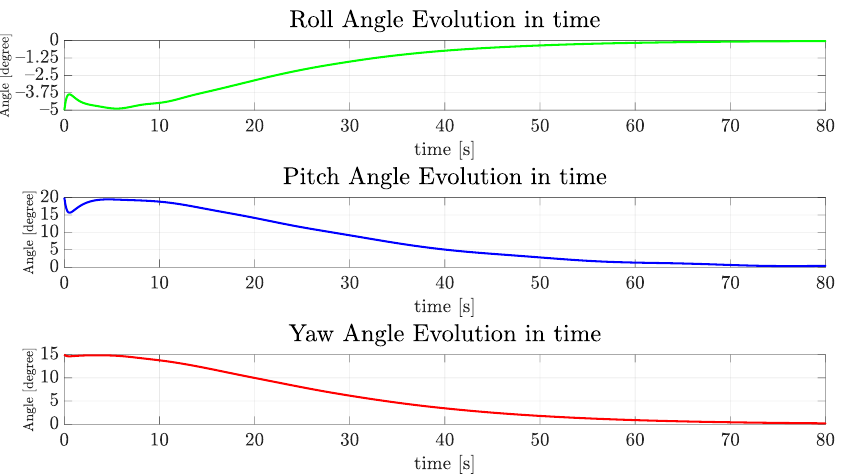
Figure 22. The evolution of orientation components of the simulated vehicle over time for the sinusoidal